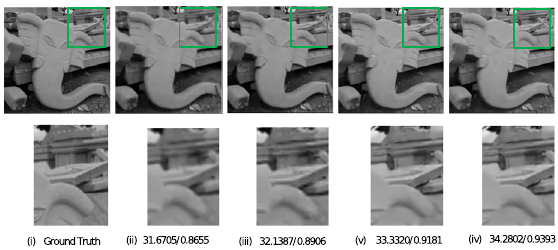
Figure 3. Result of enhancement on Sculpture image with PSNR and SSIM values (i) Ground Truth (ii) Degraded low resolution Image (iii) Result of conventional IBP enhancement technique (iv) Result of Edge preserving IBP (v) Result of the proposed method.